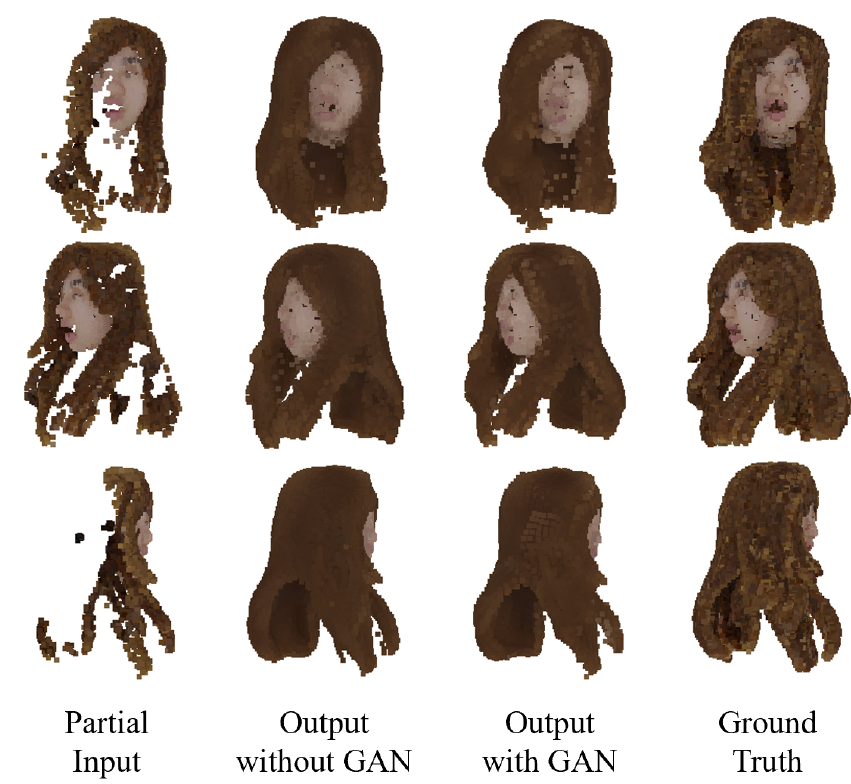
Figure 10. Completion example 3 using the proposed